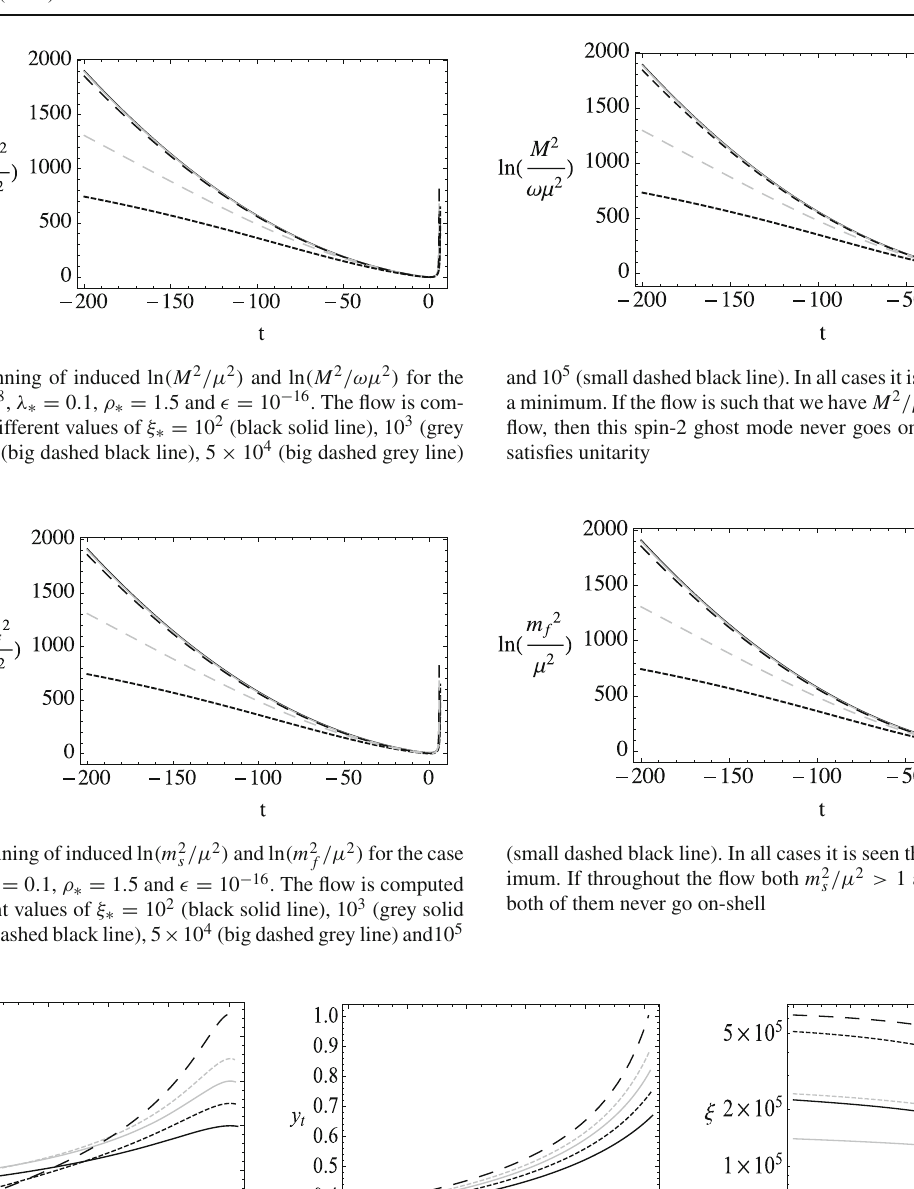
Fig. 10 Running for couplings λ , y t and ξ in left, centre and right, respectively. These are plotted for f 2 ∗ = 10 − 8 , λ ∗ = 0 . 2 (black solid line), 0 . 25 (black short-dashed line), 0 . 3 (grey solid line), 0 . 35 (grey short-dashed line) and 0 . 45 (black long-dashed line). We took ρ ∗ = 1 . 5 and ξ ∗ = 10